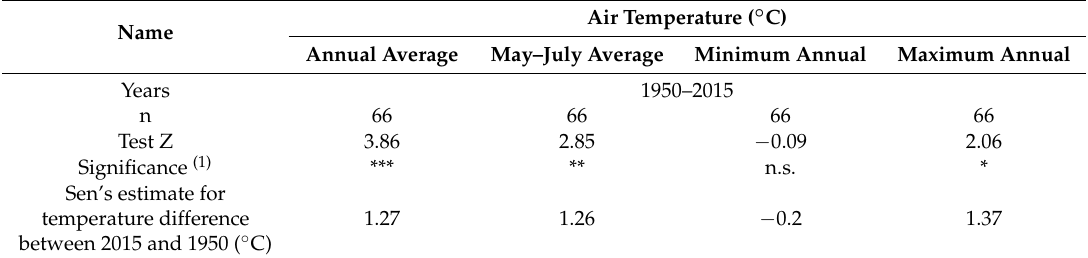
Table 1. Seasonal Mann-Kendall test statistics for time series of air temperature in Bialowieza.